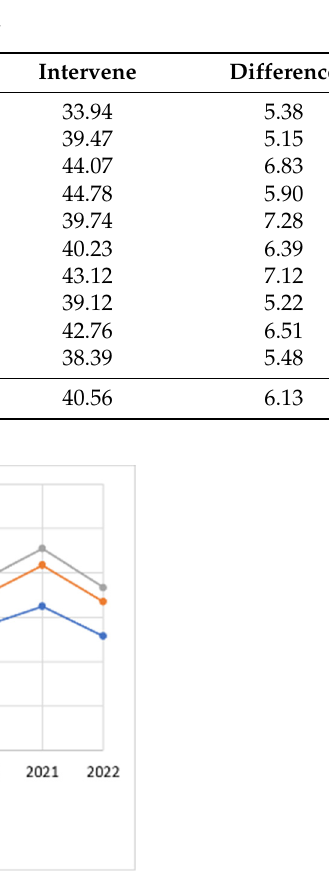
Table 18. Distribution of settlement category per IUHI class of action.